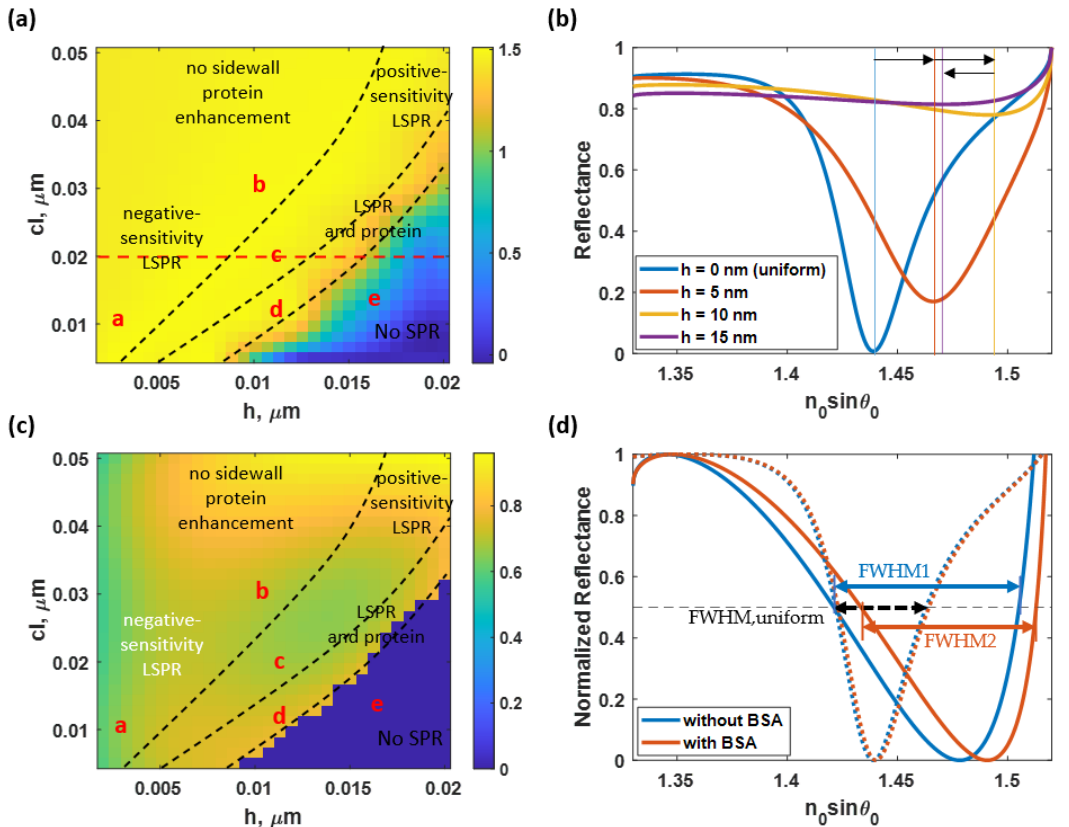
Figure 10. ( a ) the average plasmonic dip location, n 0 sin θ sp , for the three models at different roughness levels, and ( b ) the reflectance spectra from the nonprotein coated model at h of 0 nm (ideal smooth), 5 nm, 10 nm, and 15 nm, and the equivalent cl of 20 nm. ( c ) The FWHM of the SPR detection at different degrees of roughness and ( d ) reflectance spectra for the rough gold surface of h and cl of 18 nm and 40 nm, respectively, compared to the uniform gold surface. Note that the black arrows in ( b ) indicate the plasmonic angle shift direction when the h